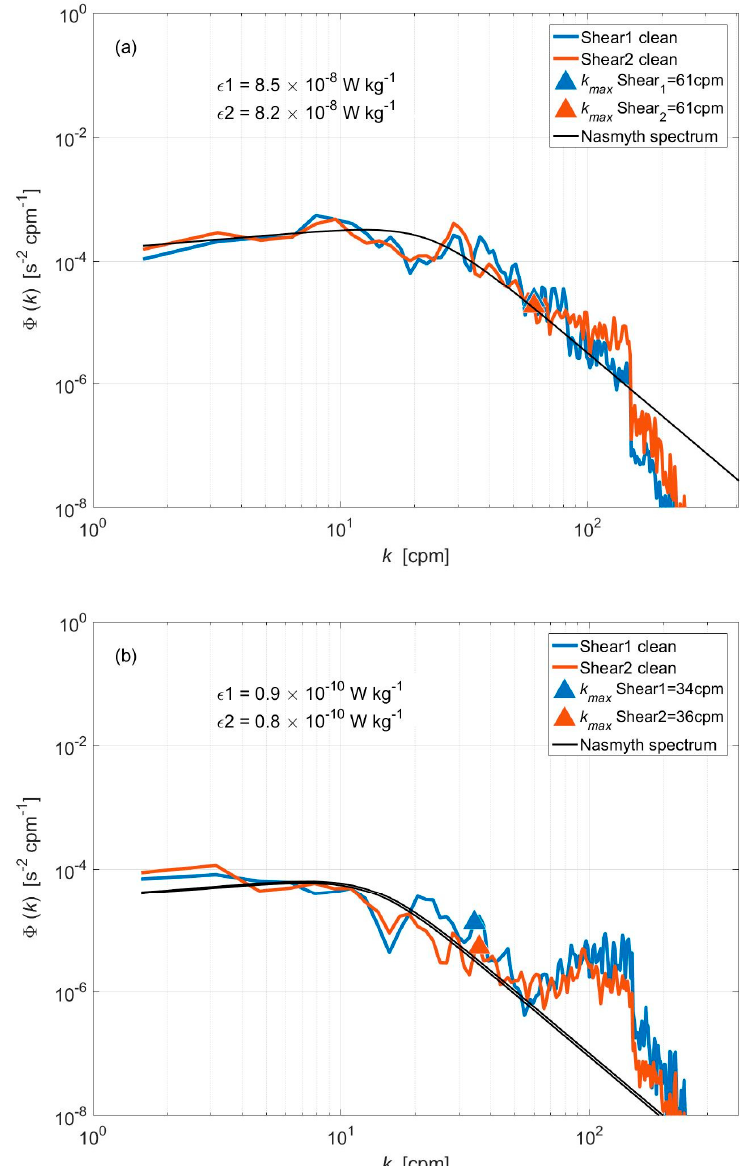
Figure 15. Shear spectra computed from the regions identified by the black ( a ) and red ( b ) rectangles in Figure 14. The green and orange lines represent the clean shear spectrum, and the black lines represent their corresponding Nasmyth spectra. The triangles (green, red) denote the upper limit of the integration wavenumber used in the computation of the dissipation rates. The corresponding ε estimate are included in each plot.